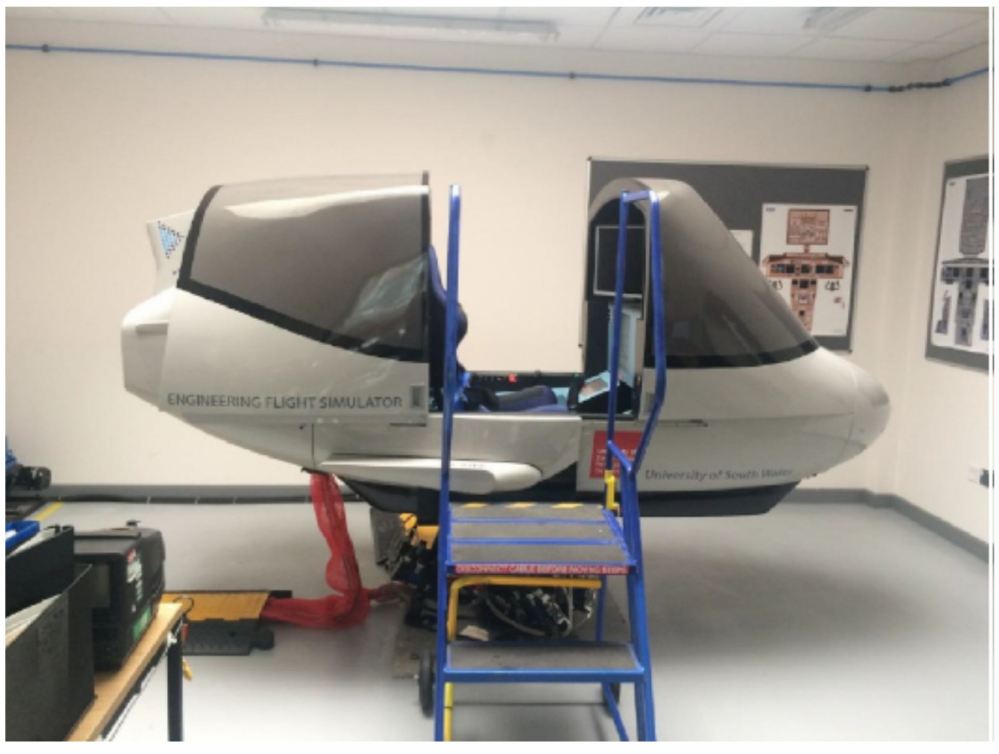
Figure 6. Engineering flight simulator capsule.